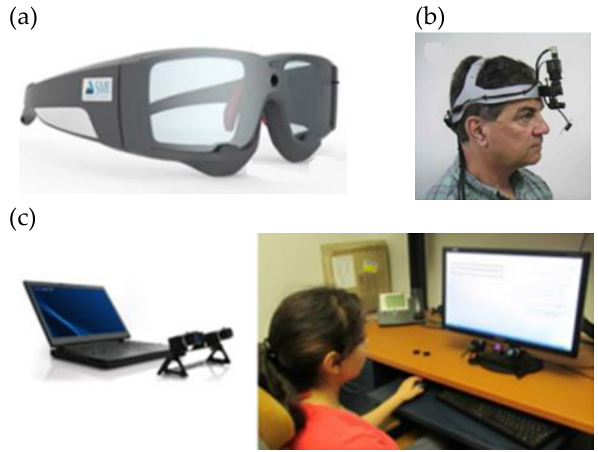
Figure 6. Sample of various kinds of eye-tracking tools: ( a ) eye-tracking glasses [314]; ( b ) helmet- mounted [315]; ( c ) remote or table [316].